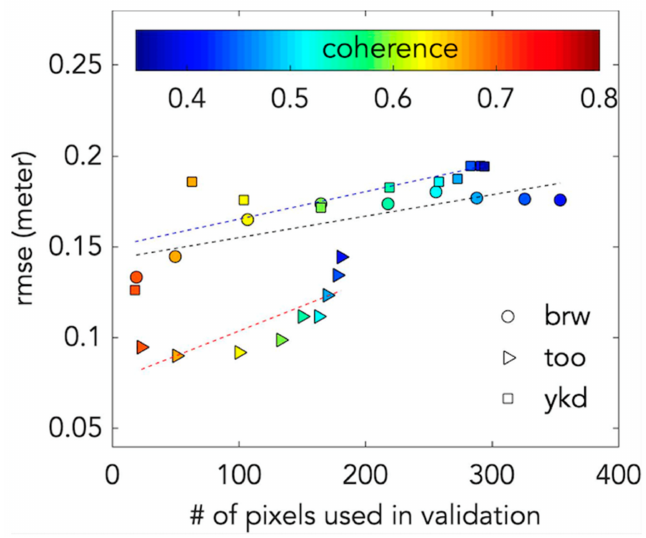
Figure 5. The relationship between the number of pixels used for validation and the resulting RMSE, showing that when SAR pixels are culled by coherence, a smaller RMSE can be achieved at the expense of a smaller statistical population.